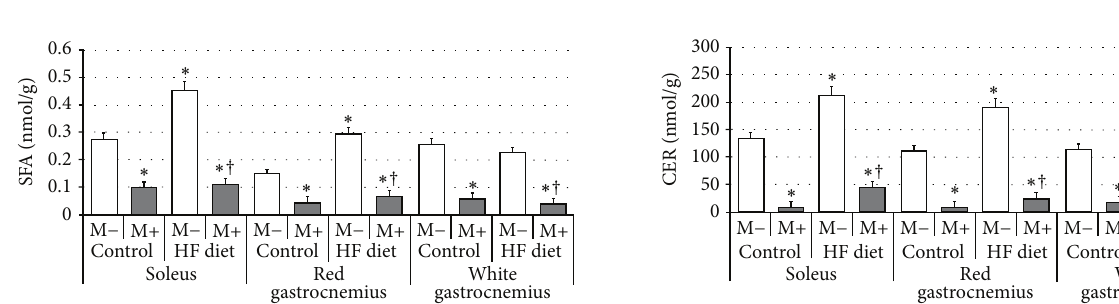
Figure 2: Effect of high-fat diet (HFD) feeding (5 weeks) and/or myriocin application (7 days) on ceramide (CER) content in skeletal muscles ( 𝑛 (per group) = 8). M+: rats administered with myriocin. M − : untreated group. Results are expressed as means ± SD. ∗ 𝑝 < 0.05 compared with control group. † 𝑝 < 0.05 compared with HF diet